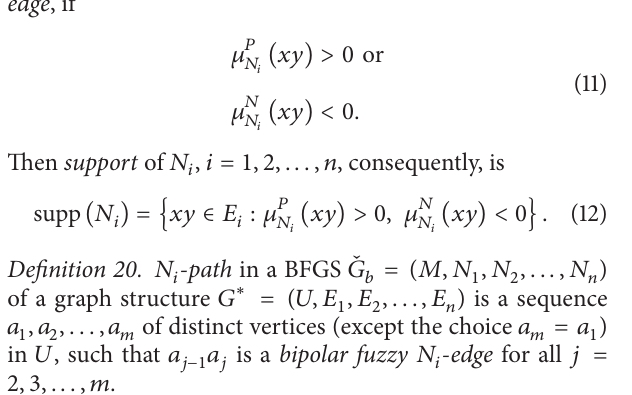
Figure 2: Bipolar fuzzy subgraph structure